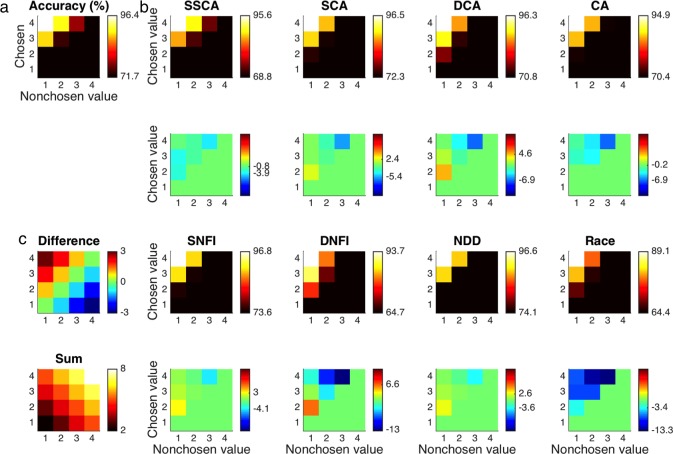
Choice accuracy.(a) Choice accuracy (i.e., the probability of correctly choosing the option with greater value) as a function of both values is displayed first for the empirical data set. Only the probabilities of correct choices are provided in the upper-left corners of each panel to avoid redundancy. (b) Accuracy is likewise shown for data sets simulated with each of the computational models in the first and third rows. Differences between model predictions and observed results are highlighted in the second and fourth rows. (c) The differences between chosen and nonchosen values and their sums are provided for reference.